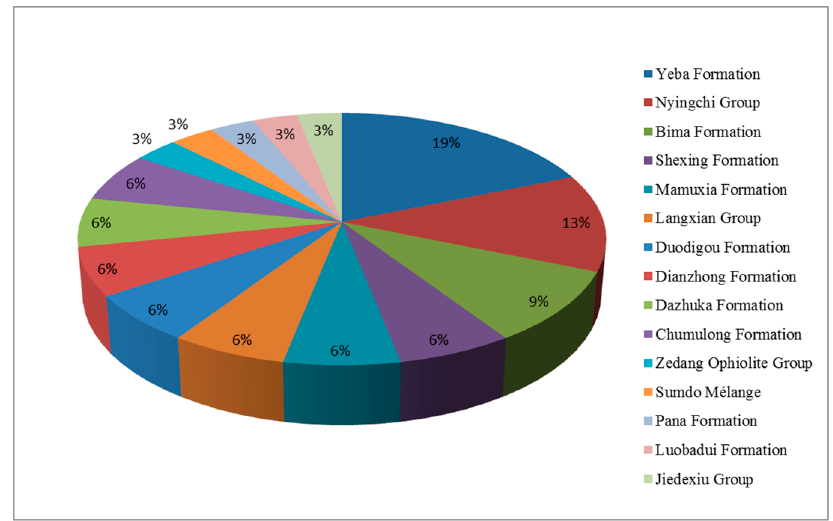
Figure 2. The ratio of deposit numbers in each stratum to total deposits.